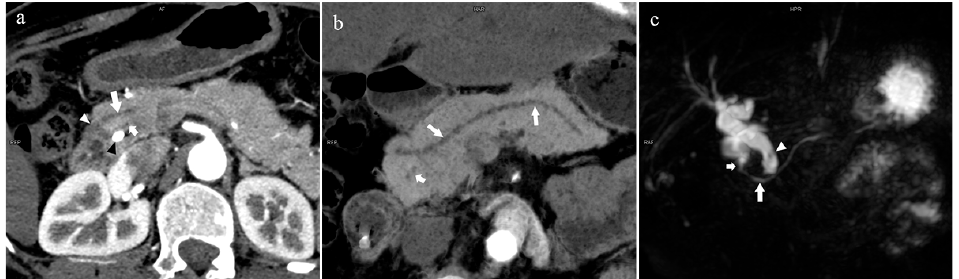
Figure 7. Complete pancreas division (Type 4a). A 42-year-old female patient with common bile duct stones. ( a ): MIP [45keV MEI(+)] shows that the MPD (long arrow) flows into the MiP (arrowhead) and the APD (short arrow) flows into the MP. There is no communication between MPD and APD. The T-tube (black arrow) can be seen in MP and the common bile duct. ( b ): MinIP [45keV MEI(+)] more intuitively shows the overall shape of MPD (long arrow) and APD (short arrow). MPD flows into MiP and extends to the tail of the pancreas. ( c ): Oblique coronal thick slab MRCP image shows MPD (long arrow) flows into the MiP (short arrow) and the APD is not displayed. The stone (arrowhead) is located in the middle and lower part of the common bile duct. MPD refers to anatomically large and functionally dominant ducts.